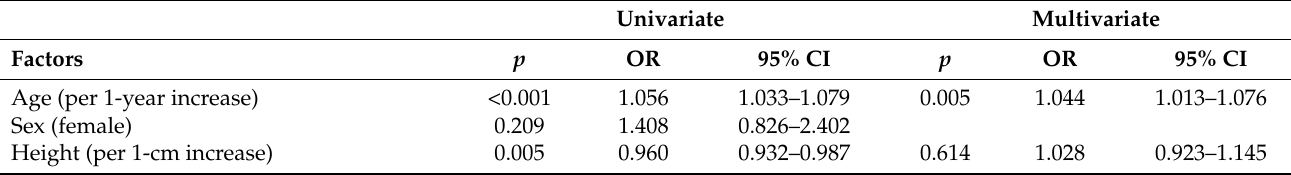
Table 3. Uni- and multivariate analyses of pre-treatment factors contributing to glecaprevir/ pibrentasvir-induced liver injury.